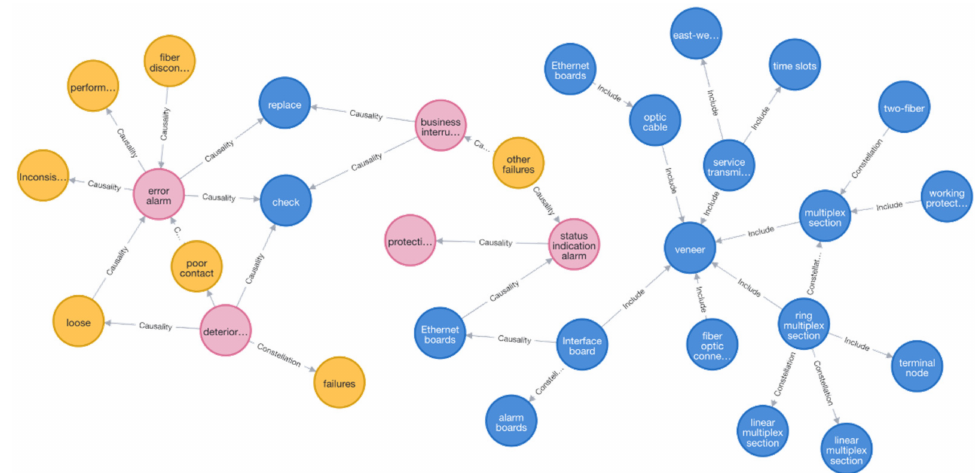
Figure 12. Fault knowledge graph of